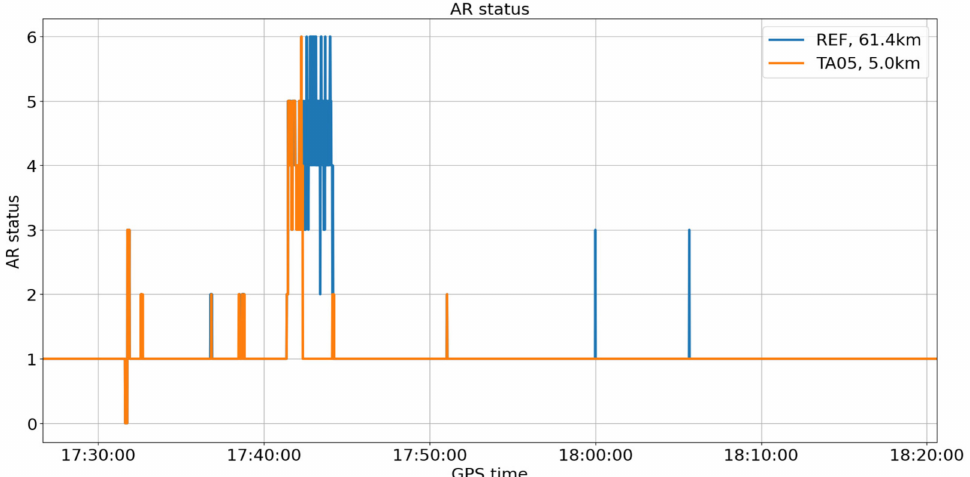
Figure 14. A comparison of the ambiguity resolution (AR) status (quality factor) for the shortest and the very long baseline in Case 2. The AR status levels indicate different levels of accuracy explained in [38]: 1 = Fixed, 2–4 = Converging float, 5–6 = DGPS, 0 = No